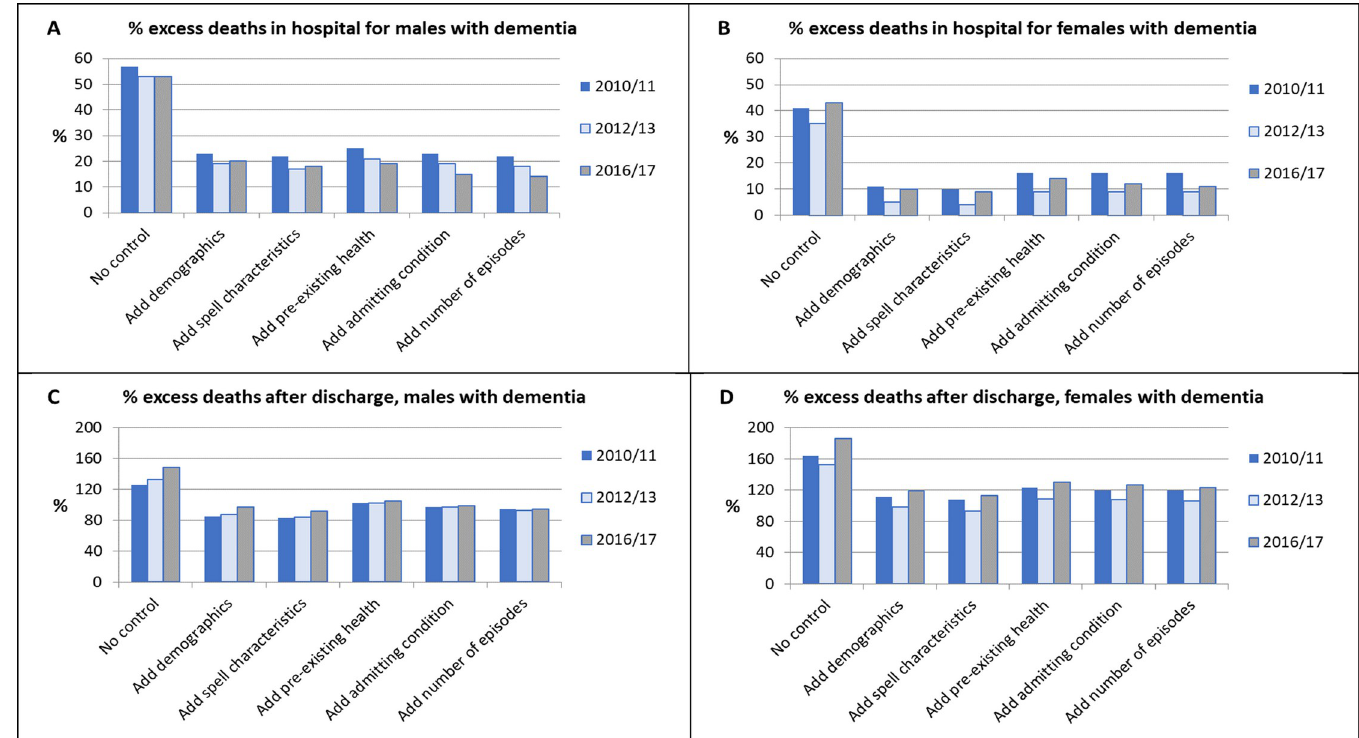
Fig 3. Patient group differences resulting from each step in the hierarchical regression analysis for deaths in hospital and deaths post-discharge. For death as an outcome, discharge destination was excluded from the models.